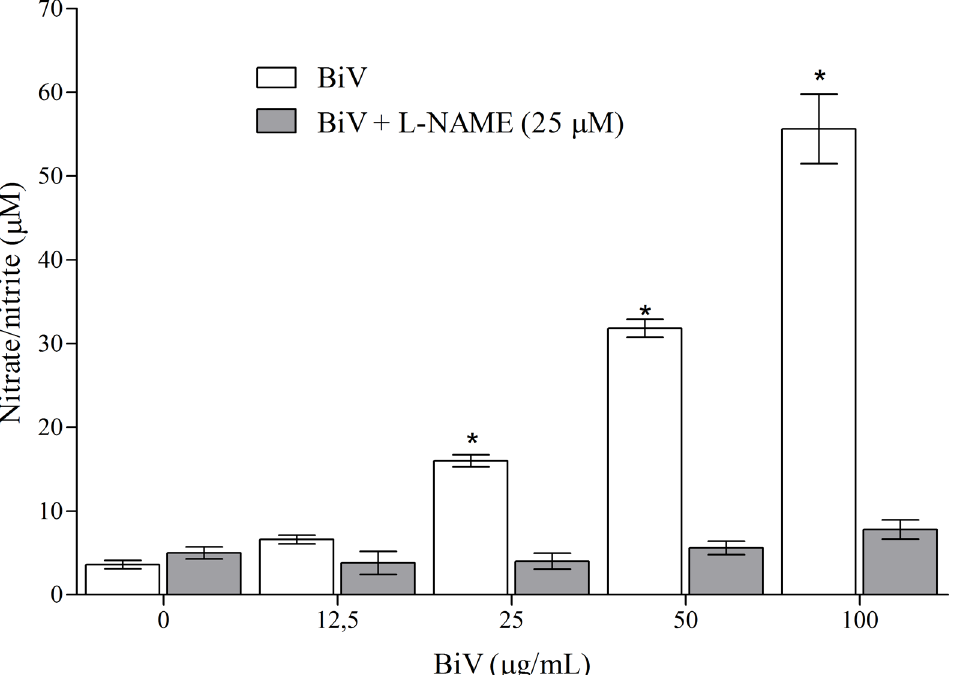
Fig 6. Analyses of nitrate/nitrite concentrations in macrophages after treatment with BiV with and without L-NAME. The analysis was performed using Griess method with modifications. * p < 0.05 vs. control